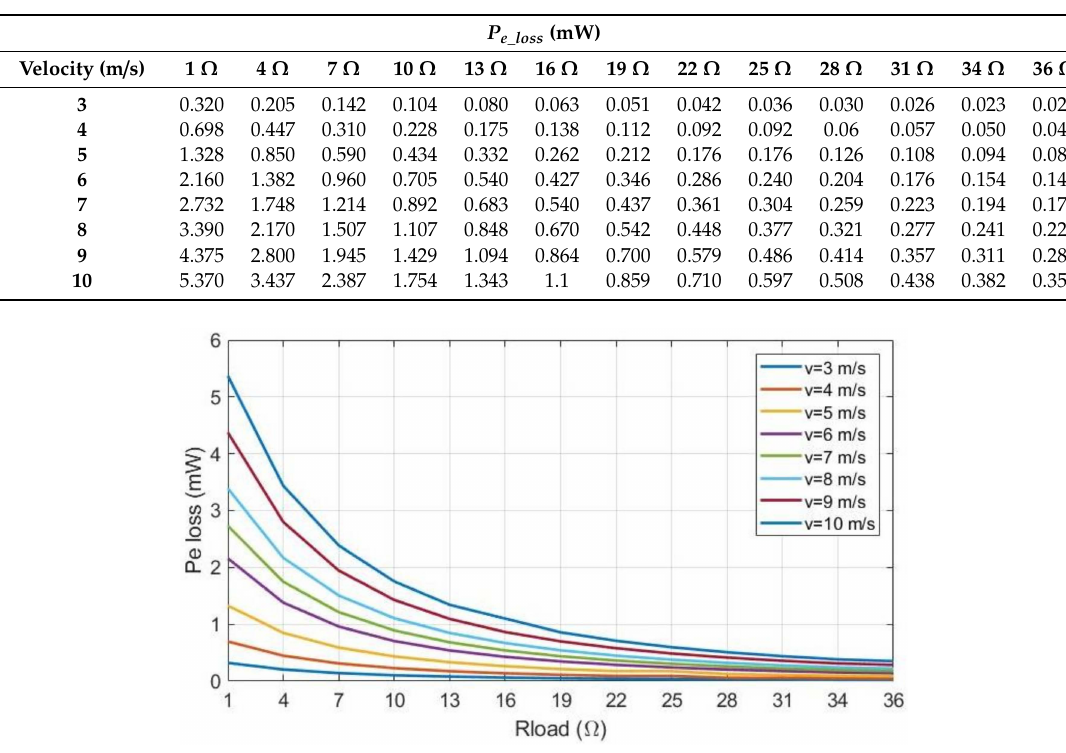
Figure 10. Calculated harvester electric losses for di ff erent loads and air velocities.